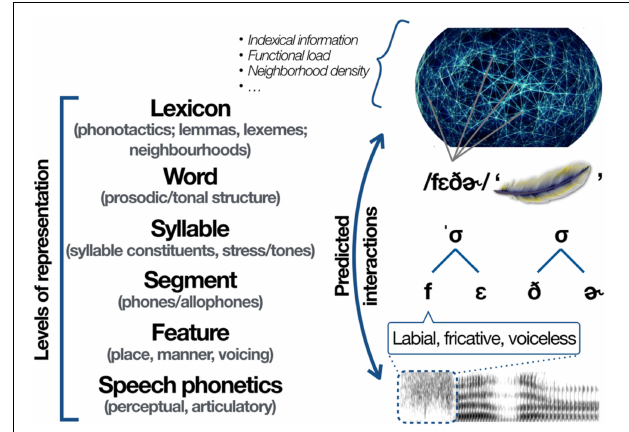
FIGURE 1 | General model of phonology, from speech phonetics to the